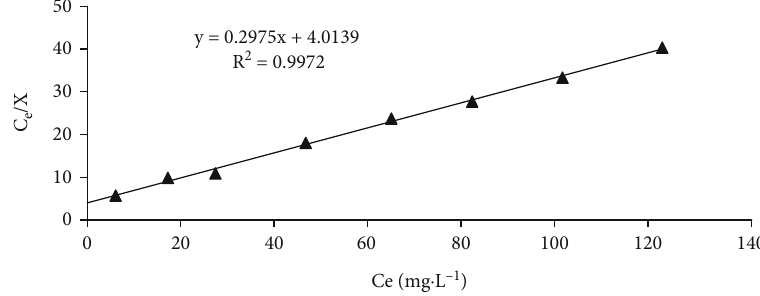
Figure 6: Langmuir isotherm plot for adsorption of M.B on BTW.